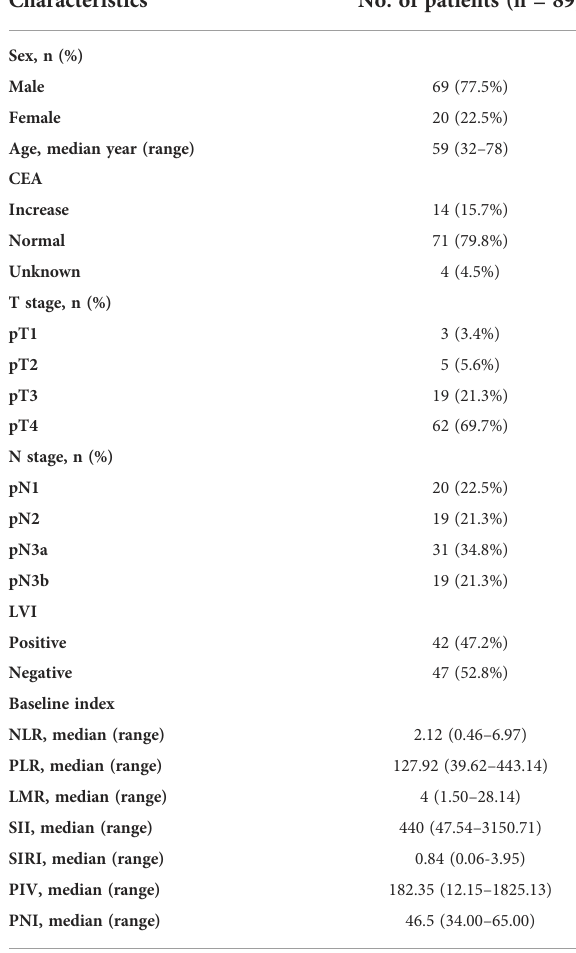
TABLE 1 Clinicopathological characteristics of the study cohort.